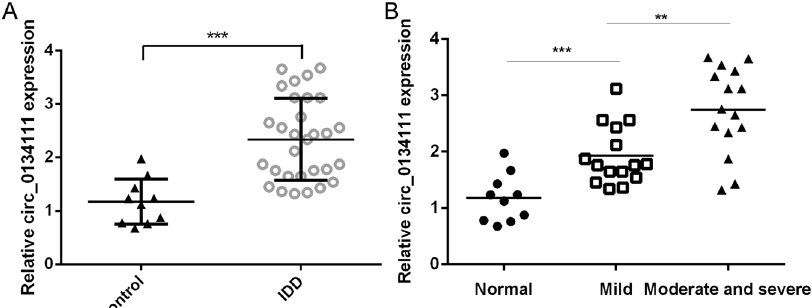
Fig. 1 circ_0134111 expression was increased in IDD tissues. A The expression of circ_0134111 in disc tissues collected from 30 IDD patients and 10 control subjects was measured by qRT-PCR. B The expression of circ_0134111 was higher in the moderate/severe than the normal IVD tissues or the mild group. ** p < 0.01 and *** p < 0.001.